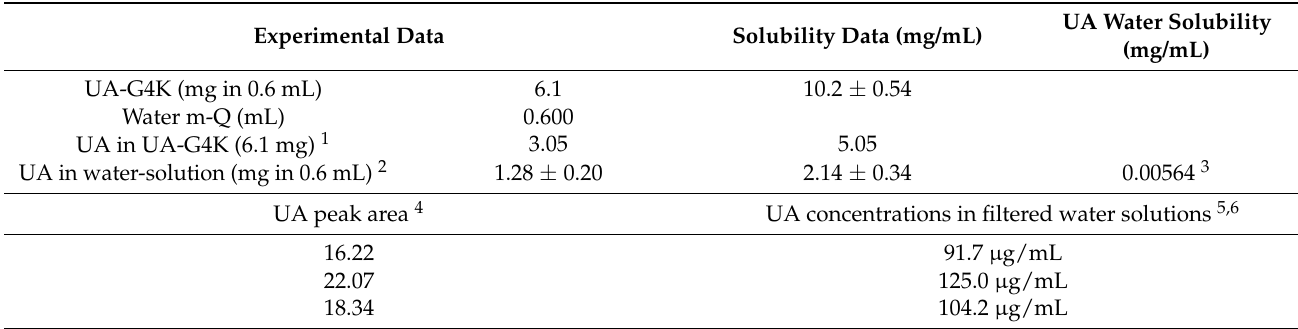
Table 3. Results obtained from solubility experiments and water-solubility of pristine UA as reported in literature.